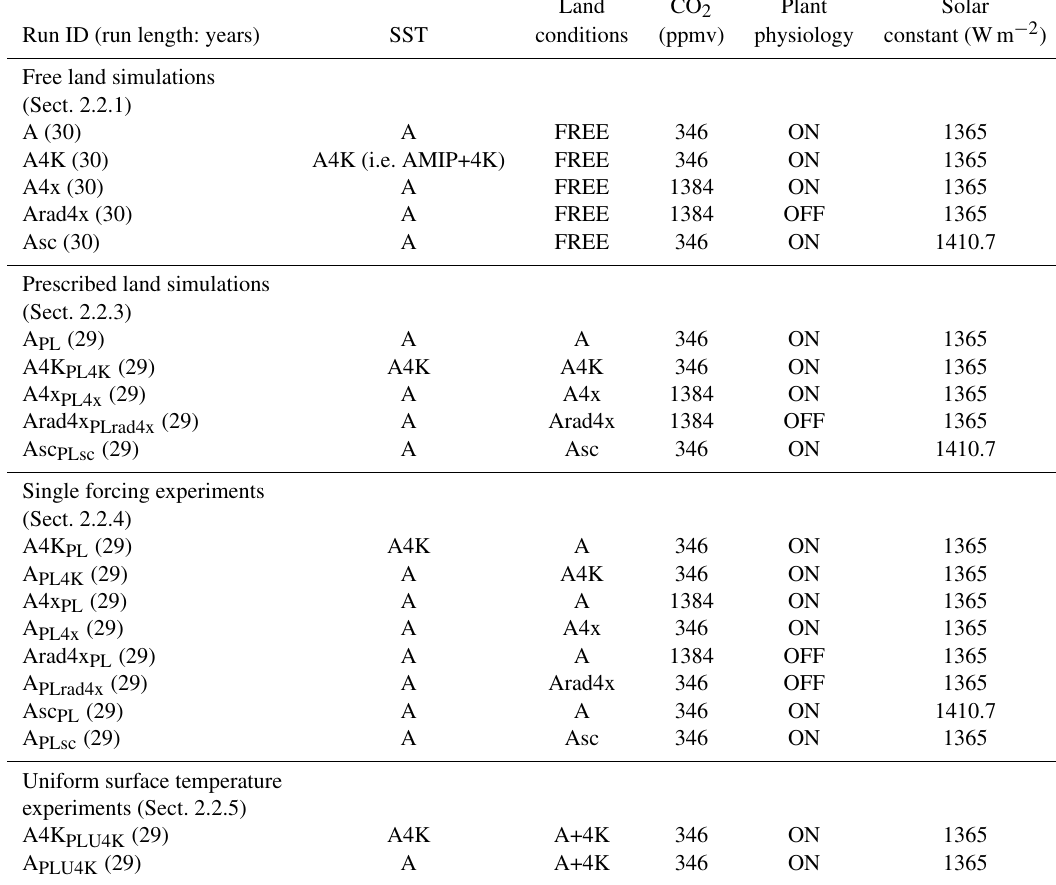
Table 1. A summary of the experimental specifications. In the sea surface temperature (SST) column, A refers to SSTs from the AMIP run and A4K to those of the AMIP+4K (A4K) run. FREE refers to freely varying land temperatures and soil moisture. Plant physiology is set to ON when vegetation responds to CO 2 changes and OFF when it uses the default value (346ppmv); i.e. only atmospheric radiation responds to higher CO 2 . Experiments are ordered following the descriptions in Sect. 2.2.1, 2.2.3, 2.2.4 and